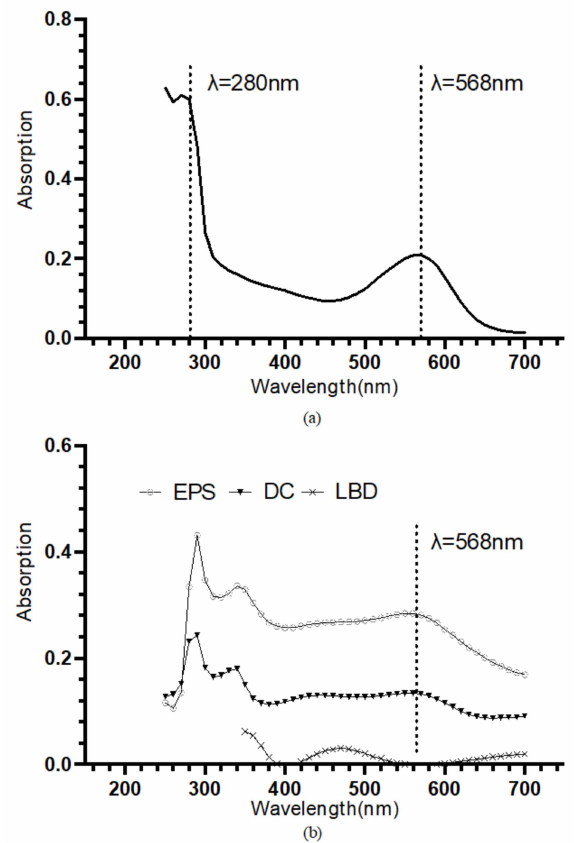
Figure 2. ( a ) UV-VIS absorption spectrum of the bR solution. An absorption peak at approximately 568 nm and an A 280 /A 568 of 2.87 indicate a high purity. ( b ) UV-VIS absorption spectrum of the bR films immobilized with different immobilization techniques. Dropcasted film and electrophoretic sedimented film show the absorption peak at around 568 nm, verifying the successful transferring of bR molecule; Langmuir–Blodgett deposited film showed a considerably low absorption through the entire range, indicating a small amount of protein